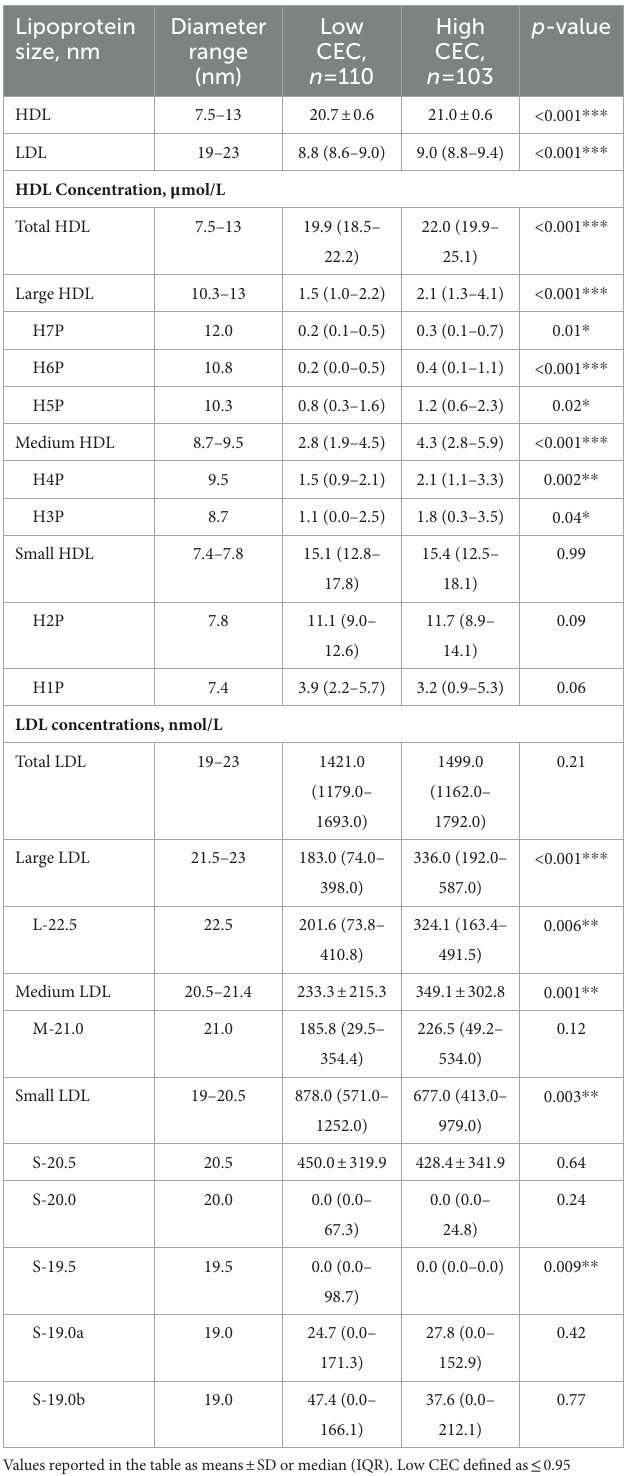
TABLE 2 Comprehensive lipid panel using novel LP4 algorithm of psoriasis stratified by median CEC (0.95). Lipoprotein size,